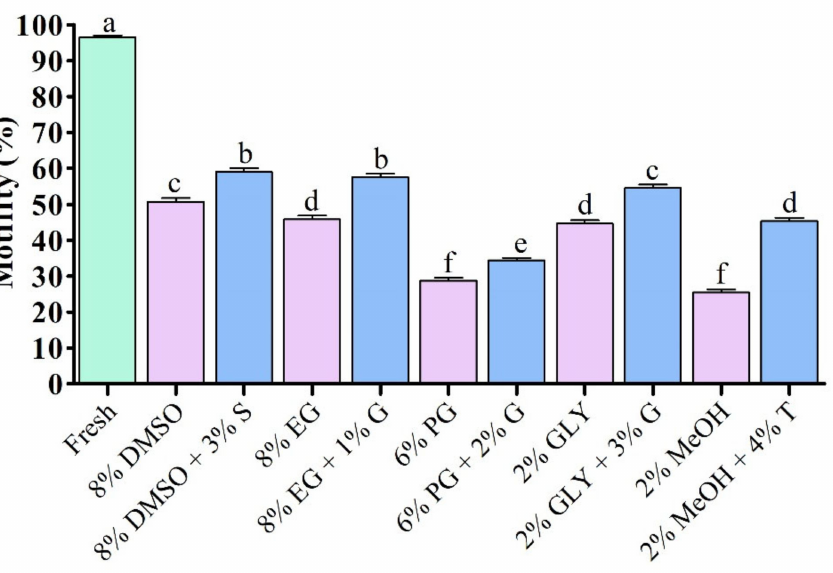
Figure 1. Post-thaw motility of saccharide supplemented cryopreserved sperm of Pacific